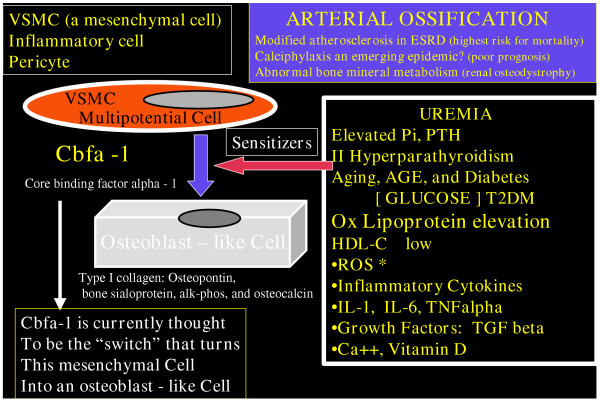
Sensitizers and the Cbfa-1 "protein switch" to transform mesenchymal cells into osteroblast-like cells. This slide demonstrates the transformation of the pluripotent mesenchymal VSMC and pericyte into an osteoblast-like cell. It reveals the importance of the ossification sensitizers and core binding factor alpha-1 Cbfa-1 emphasizing their important role in VOC.